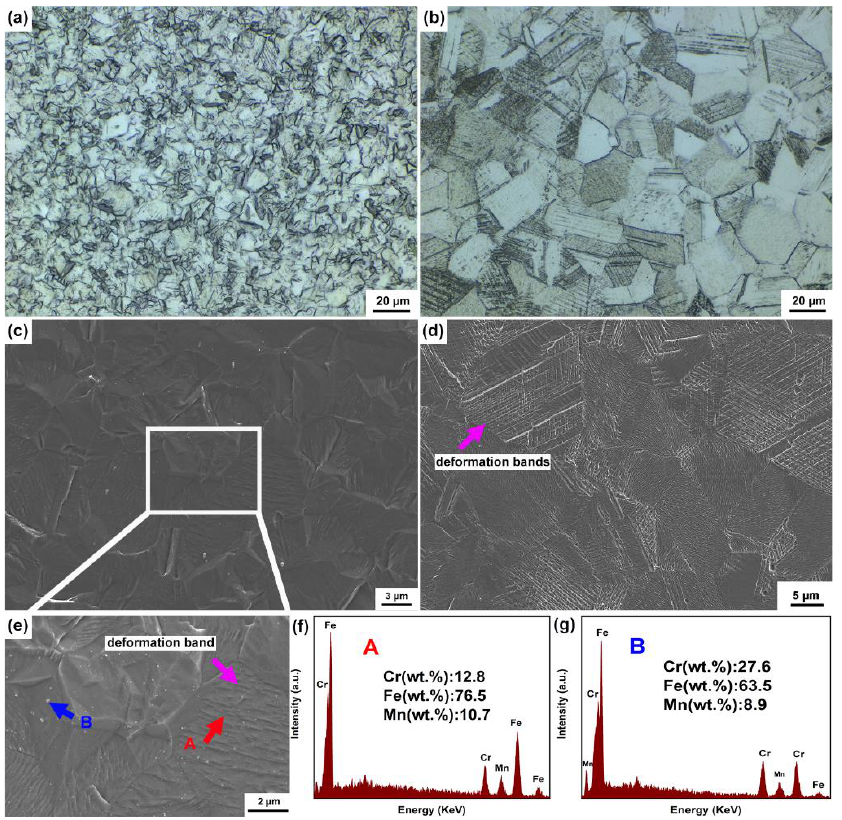
Figure 2. The metallographic images of ( a ) CR-MASS, and ( b ) HR-MASS; scanning electron micro- graphs (SEM) of the experimental MASS: ( c ) CR-MASS and ( d ) HR-MASS; ( e ) shows the magnified images of the white frame in ( c ); ( f , g ) illustrate the chemical composition of point A and B in ( e ), respectively.